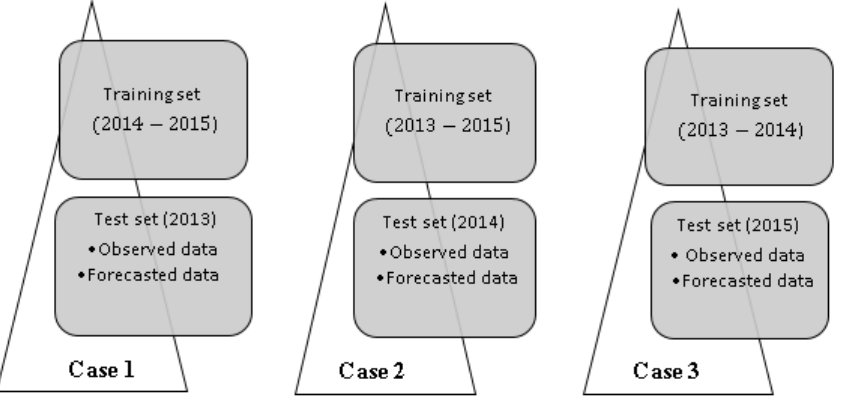
Figure 2. Scheme of the three cases tested using the spirit of k-fold cross validation